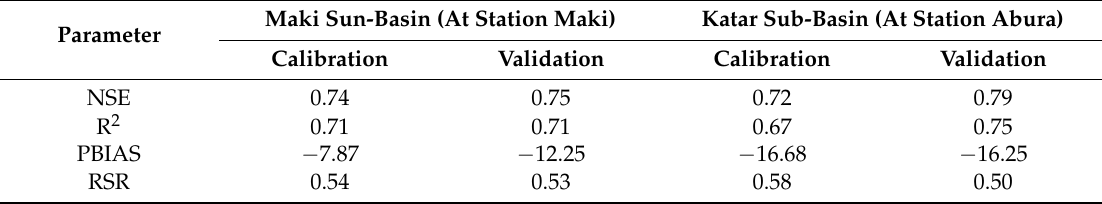
Table 2. Daily measured and simulated sediment yield calibration and validation model performance statistics.